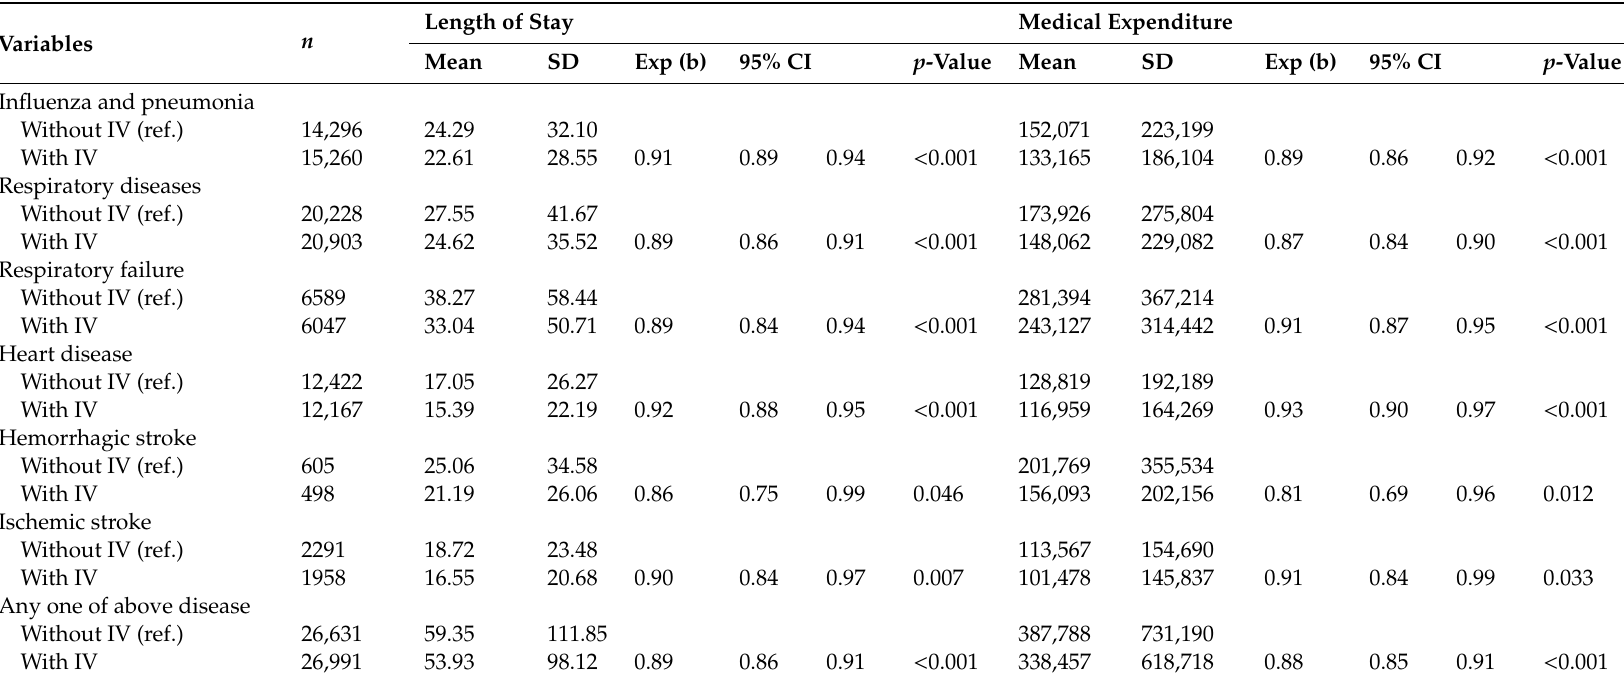
Table 2. Comparison of the length of stay and medical expenditure between the vaccinated and unvaccinated